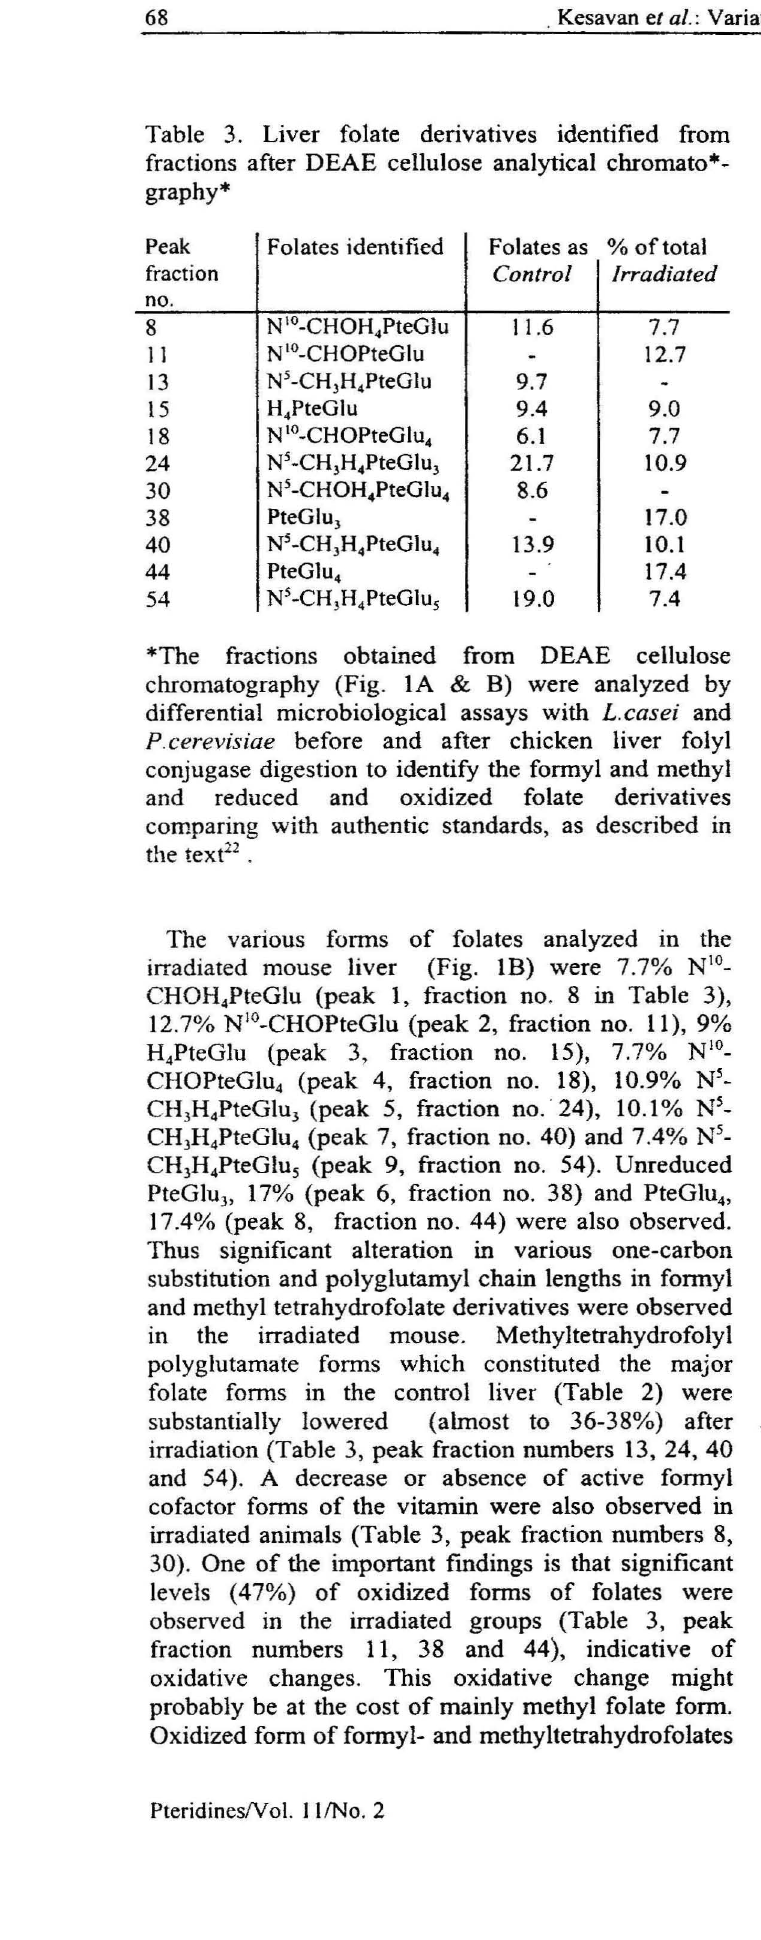
Table 3. Liver folate derivatives identified